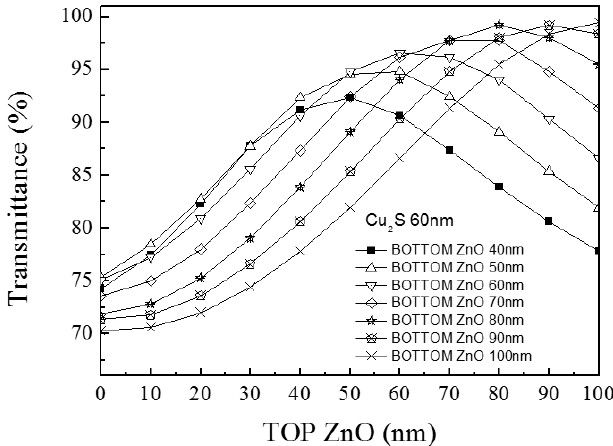
Figure 22. Comparison between simulation and experimental transmission spectrum of ZnO (30 nm)/Cu 2 S (60 nm)/ZnO (60 nm)/glass multilayer and ZnO (60 nm)/Cu 2 S (60 nm)/ZnO (60 nm)/glass multilayer.